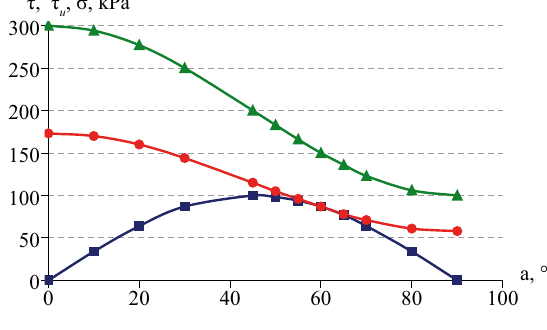
Fig. 4. Shear stresses τ and shear strengths τ u versus failure plane inclination α of clay sample: